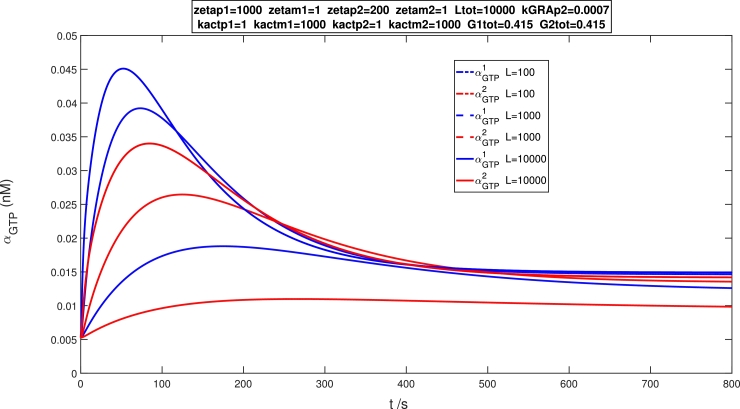
Agonist-agonist time courses, equivalent to Fig. 4, but using new rescaled parameter set. We see that the αGTP concentrations are simply rescaled.